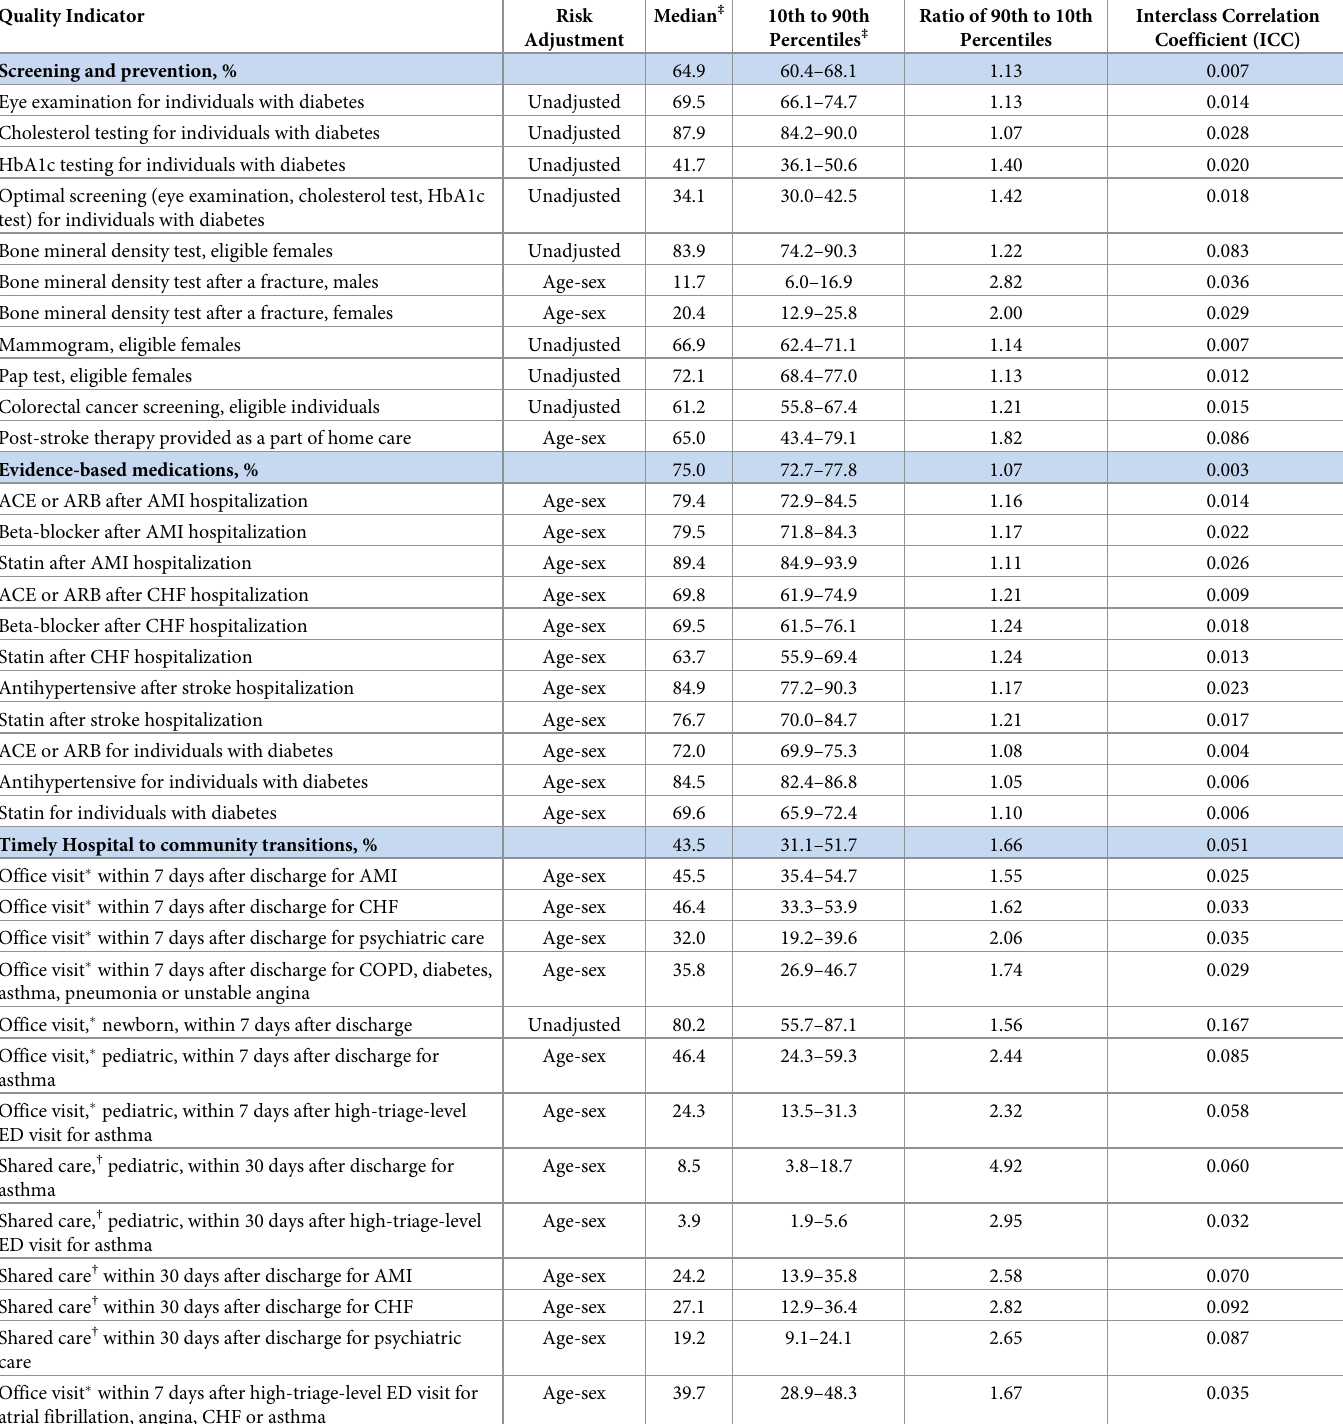
Table 1. Quality indicator rates, according to quality